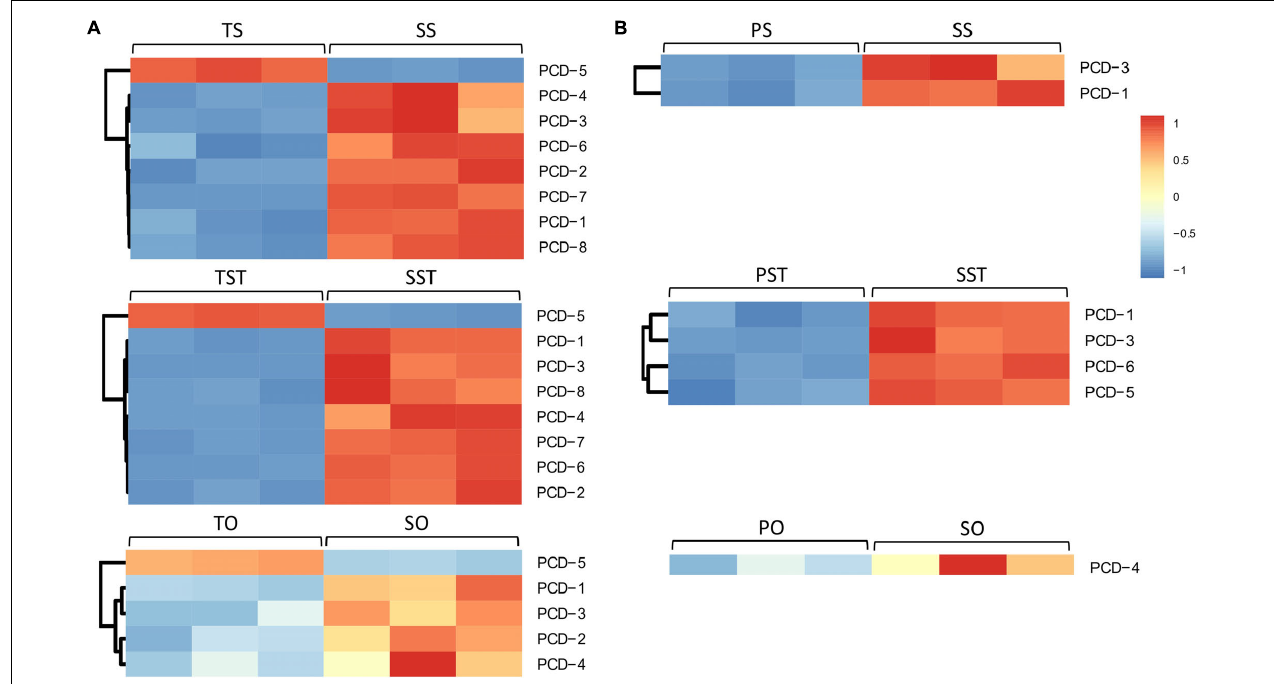
FIGURE 5 | Expression patterns of programmed cell death (PCD) genes in Seedless palm trees compared with (A) Tenera and (B) Pisifera in various floral tissues (S, stigma; ST, style; O, ovary).